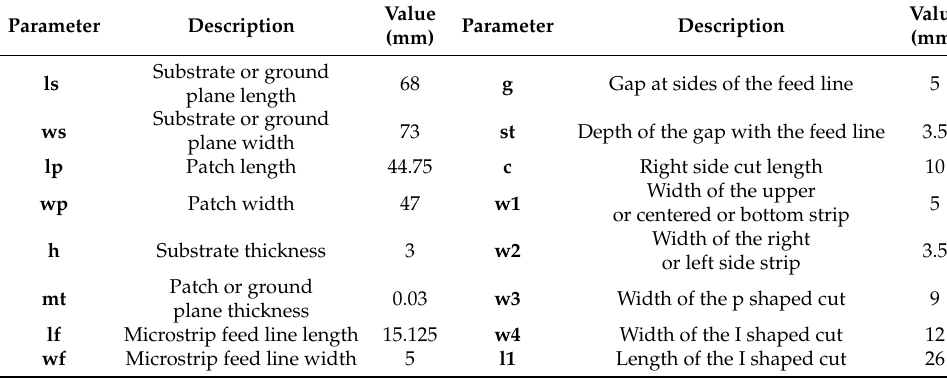
Table 1. List of simulation parameters along with their optimized